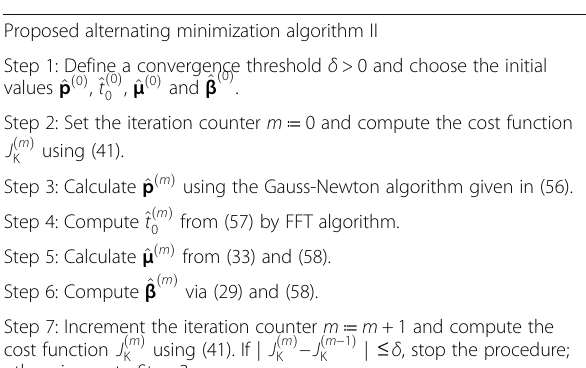
Proposed alternating minimization algorithm